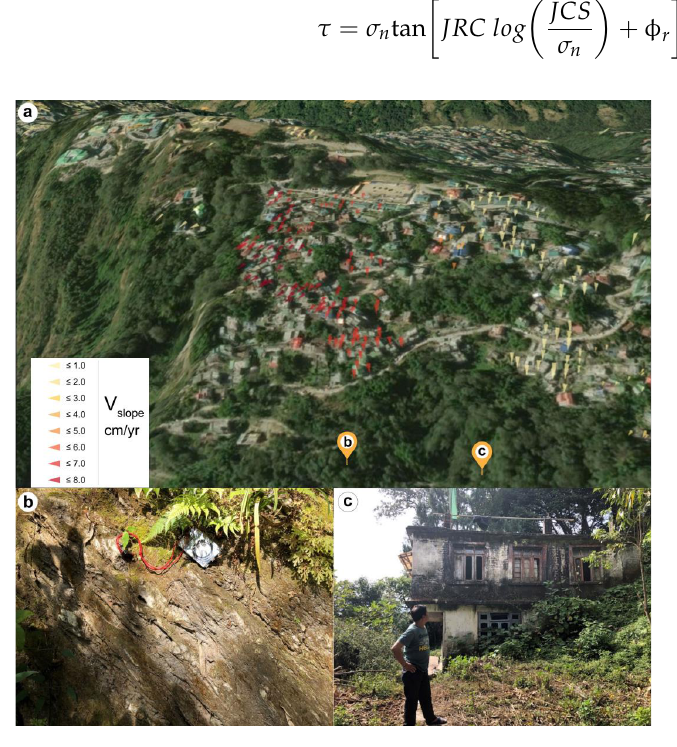
Figure 4. The InSAR observation and field investigation of Tathangchen landslide. ( a ) The Tathangchen sloping area in Gangtok, where the slope is moving at around 8–10 cm/yr. The mean velocities represent the projection of the vertical velocity field in the slope direction. ( b ) The rock outcrop shows highly weathered and foliated phyllitic rocks at the surface in Tathangchen. ( c ) Abandoned house due to settlements in the ground caused by creep at the Tathangchen area at an elevation of about 1638